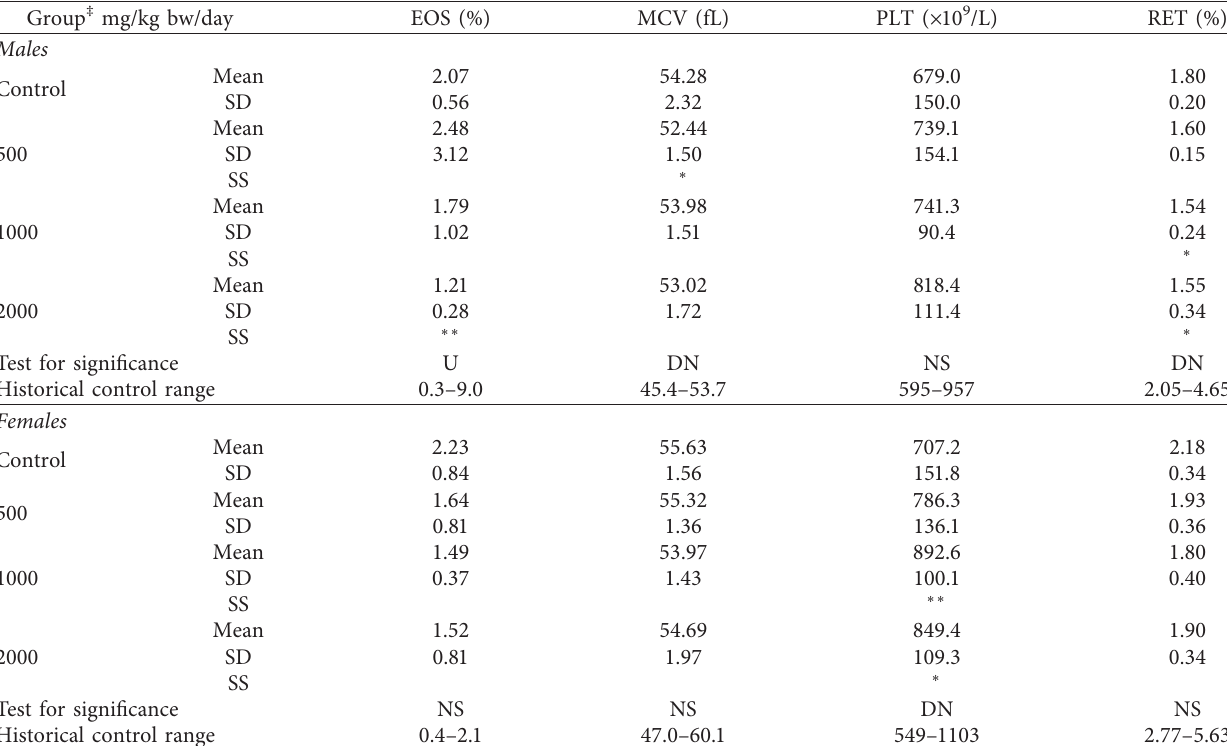
Table 8: Summary of relevant a hematology results, 90-day